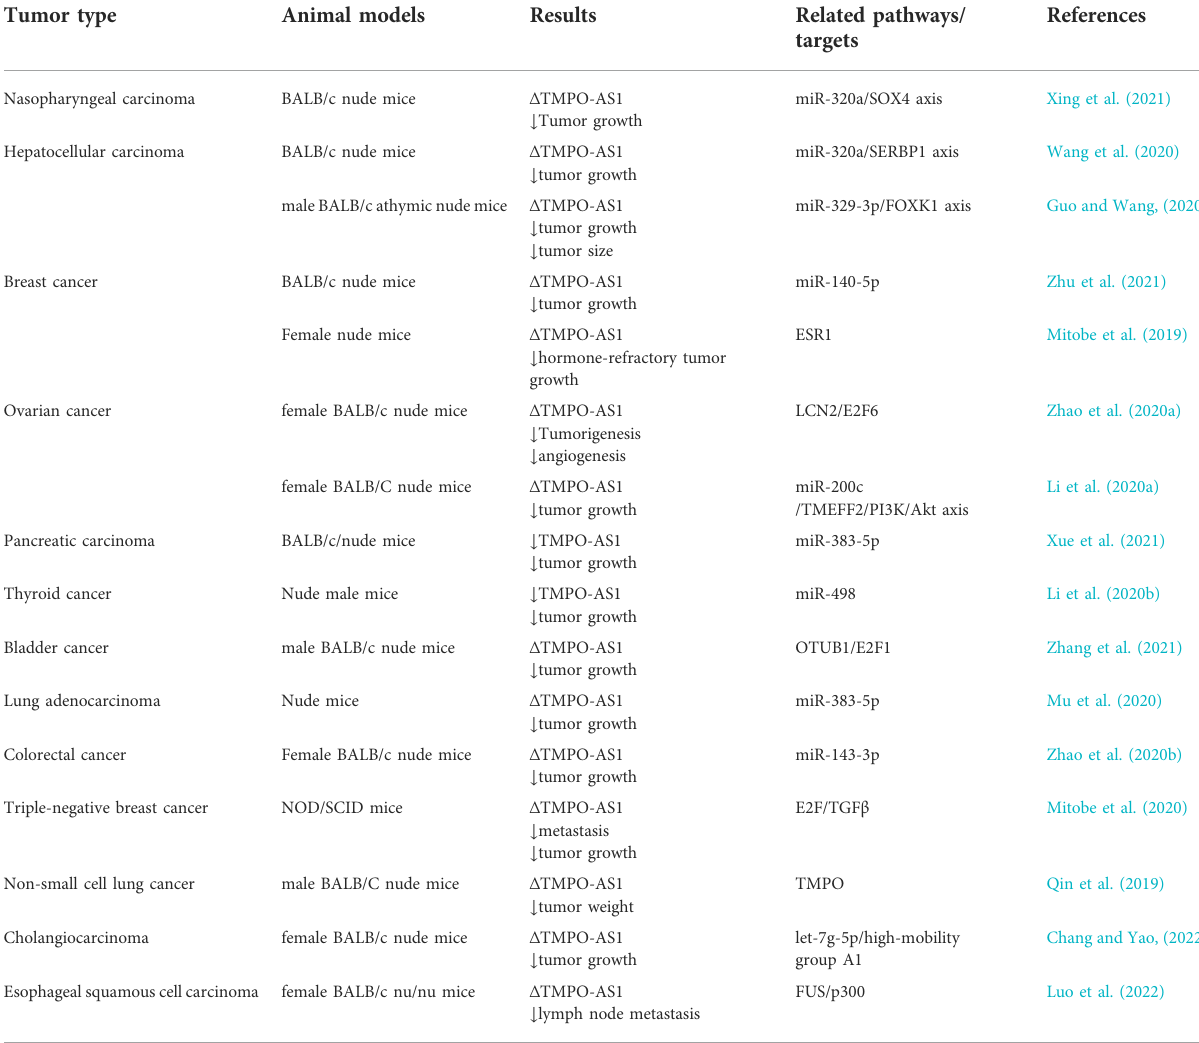
TABLE 2 In fl uence of TMPO-AS1 in carcinogenesis based on studies in animal models (NOD-SCID: non-obese diabetic/severe combined immunode fi ciency, Δ : knock-down or